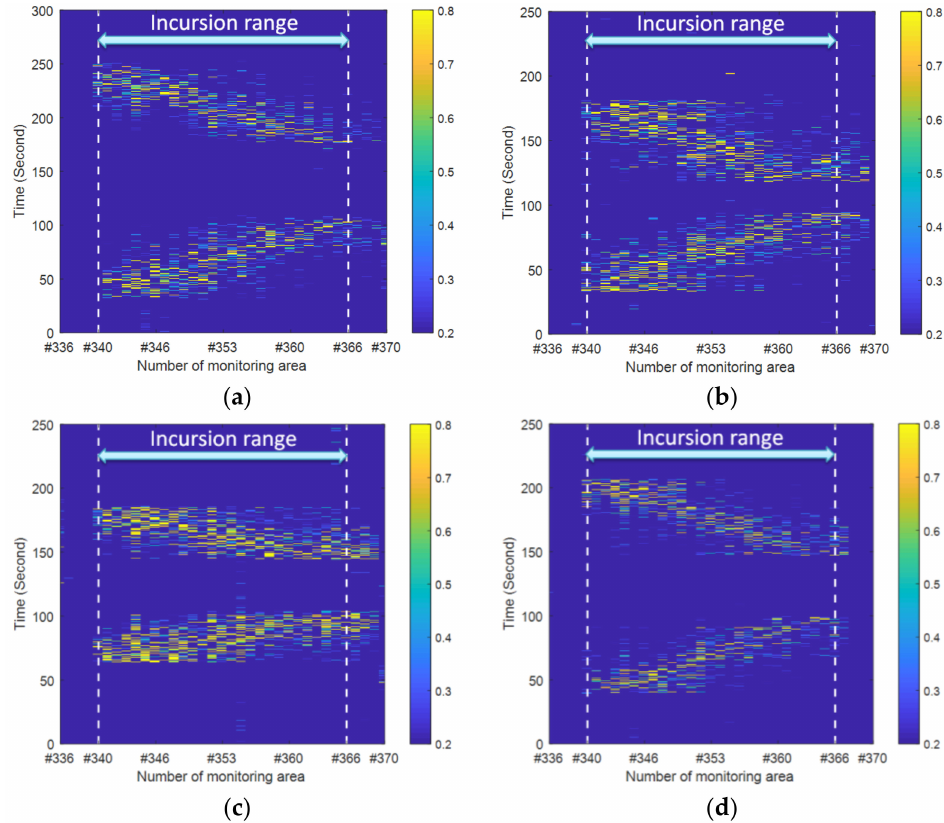
Figure 9. Vibration intensity versus space and time under di ff erent intrusion scenarios: ( a ) single person walking; ( b ) four people walking; ( c ) single person jogging; ( d ) single person walking along the other